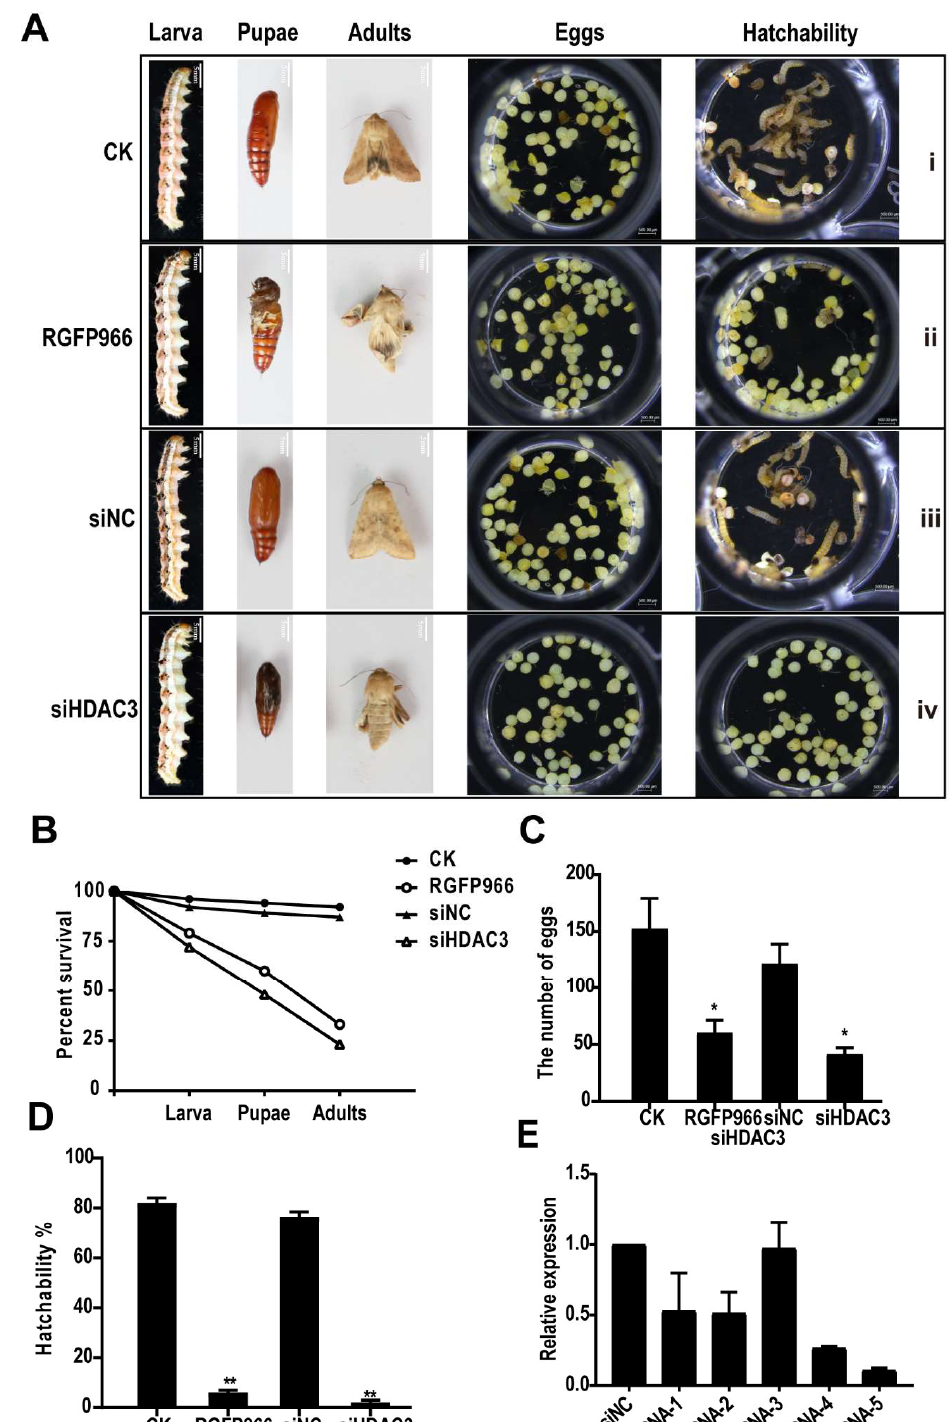
Figure 3. Phenotypes and mortality caused by HDAC3 knockdown in H. armigera . ( A ) Phenotype at different developmental stages (pupal, adult, spawning, and hatching) after treatment. (i). Newly molted 5th instar larvae fed an artificial diet. (ii). Freshly molted 5th instar larvae fed an artificial diet containing 10 µ M RGFP966, an HDAC3 -inhibitor. (iii). Treatment of newly molted 6th instar larvae with siNC. (iv). Newly molted 6th instar larvae treated with siHDAC3. ( B ) Treatment lethality in larvae, pupae, and adults. Treatment effects on ( C ) the egg laying number, and ( D ) the hatching rate. ( E ) siRNA silencing efficiency ( t -tests; * p < 0.05, ** p <